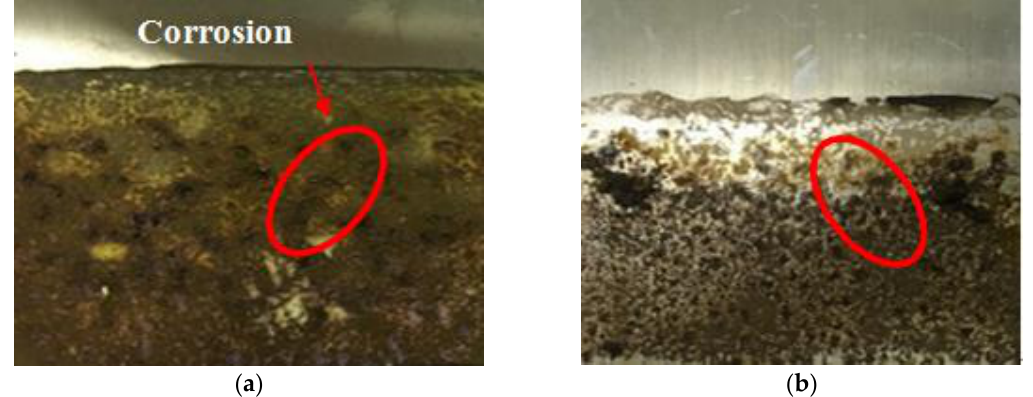
Figure 6. Electrode corrosion ( a ) Sample with no fulvic acid; ( b ) Sample mixed with fulvic acid).